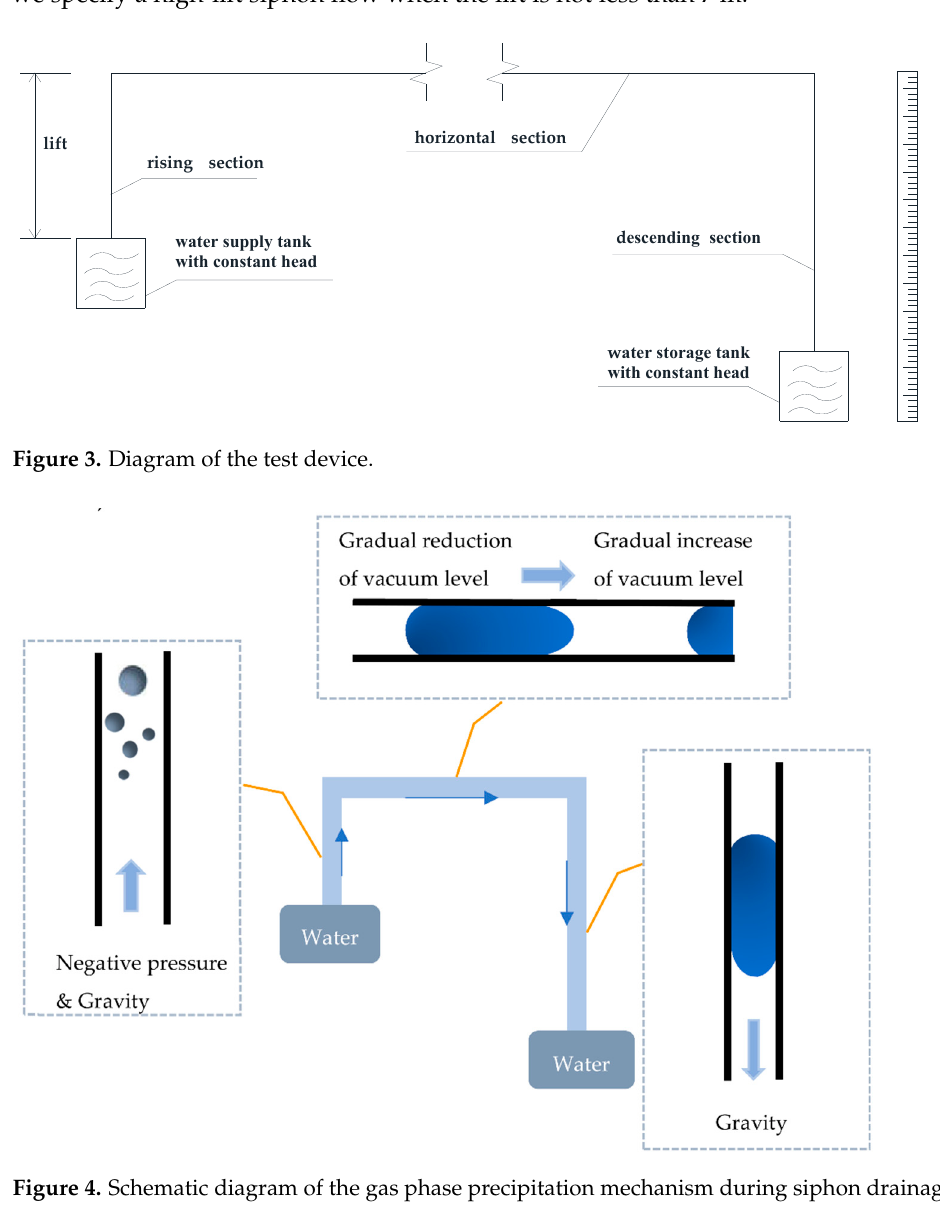
Figure 4. Schematic diagram of the gas phase precipitation mechanism during siphon drainage. Table 1. Experimental schemes of siphon drainage (T = 25 °C, 𝑃 (cid:3039)(cid:3028) = 100.53 kPa). No. 𝑫 /[mm] 𝑳 𝒉𝒐𝒓𝒊 /[m] 𝑯 𝒍𝒊𝒇𝒕 /[m]